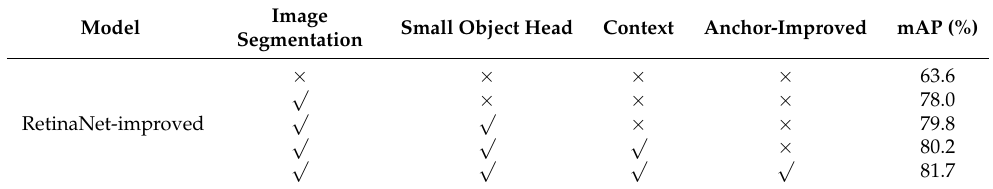
Table 4. Ablation experiments on our